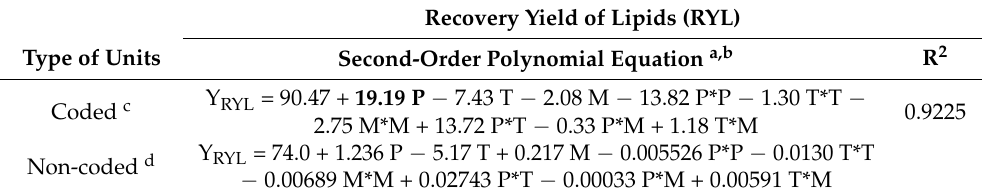
Table 2. Second order polynomial equations for the response of RYL for SC-CO 2 extraction of